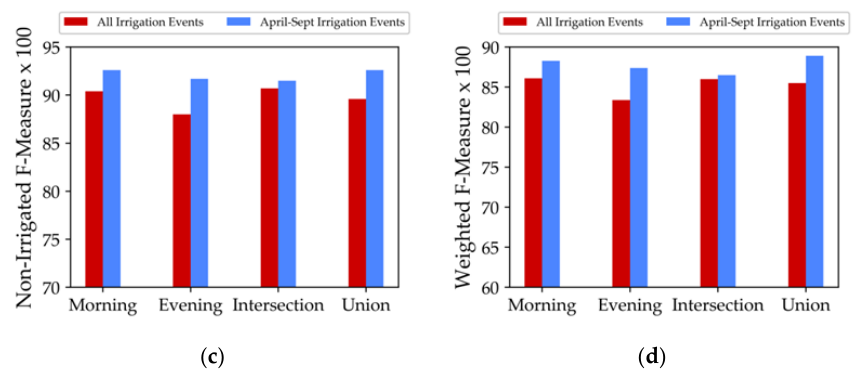
Figure 10. Comparison between accuracy metrics obtained for classification of irrigated and non-irrigated plots using all the detected irrigation events (red bar) and the detected irrigation events between April and September 2018 (blue bar). ( a ) Overall accuracy, ( b ) F-measure of irrigated class, ( c ) F-measure of non-irrigated class and ( d ) weighted F-measure.